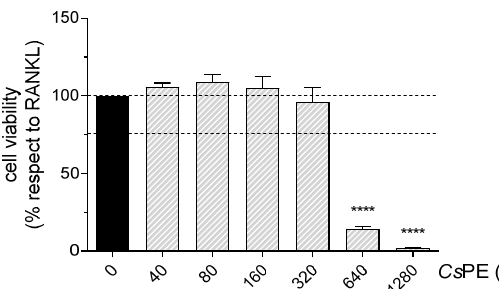
Figure 5. Cell viability analyzed by MTT assay on RANKL-differentiated RAW 264.7 treated with Cs PE. RAW264.7 cells were co-treated for 5 days with RANKL 100 ng/mL and Cs PE at the indicated concentrations. The percentage of viable cells with respect to RANKL-differentiated control was evaluated by MTT assay and reported as the mean ± SD of three independent experiments, each conducted in triplicate. Dotted lines indicate 100% and 75% of control viability. **** p < 0.0001, RANKL/ Cs PE-treated (grey bars) versus RANKL-differentiated cells (black bars) (one-way ANOVA test).